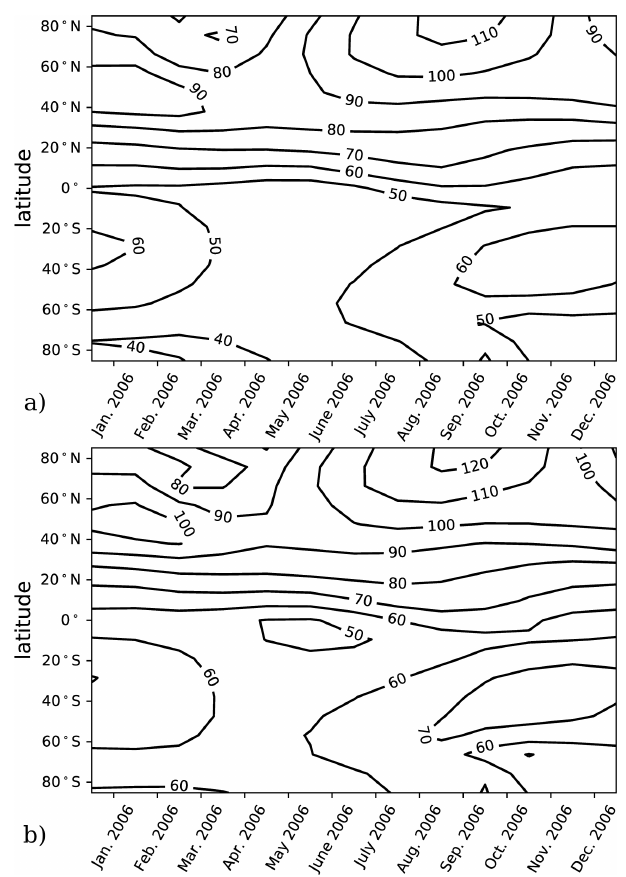
Figure 1. Column α Br as a function of latitude and season for the year 2006. (a) Model results computed using JPL-2006 pho- tochemistry and kinetics (Sander et al., 2006) for the year 2006. (b) Model results computed using JPL-2015 photochemistry and kinetics (Burkholder et al., 2015) for the year